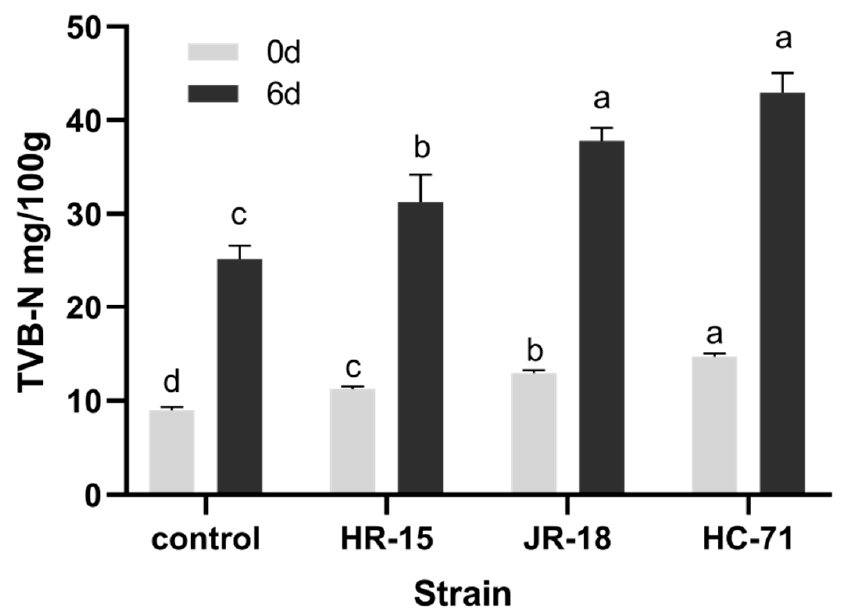
Figure 4. The TVB-N value of tilapia inoculated with different S . putrefaciens strains (HR-15, JR-18, and HC-71) and stored at 4 ◦ C. Different lowercase letters indicate significant differences at the 0.05 level ( p < 0.05). Table 4. The yield factors of the TVB-N of the tilapia flesh inoculated with different S. putrefaciens